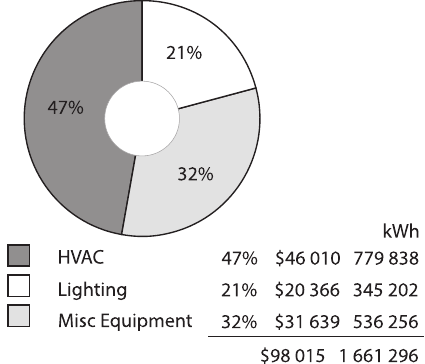
Figure 13. The schematic diagram of seasonal winds and building configuration Figure 14. Analysis of proportional power use